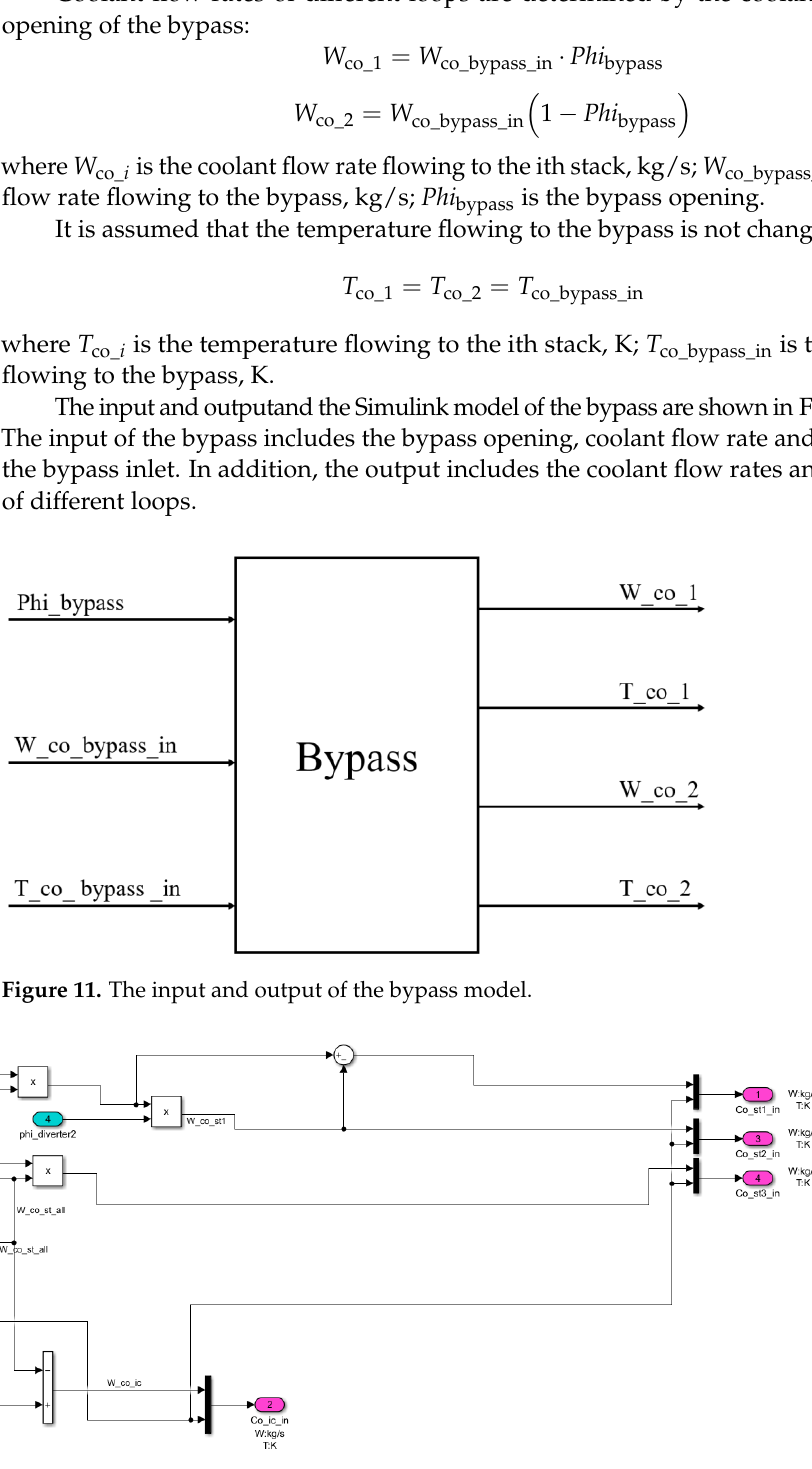
Figure 12. The Simulink model of the bypass.